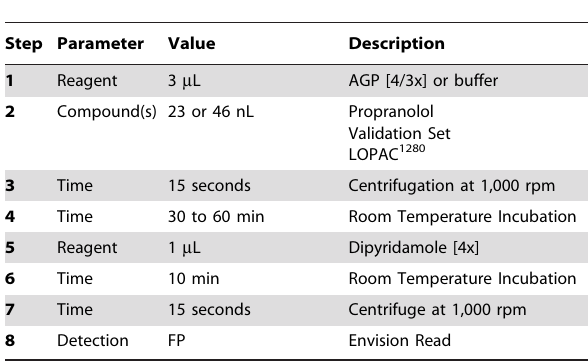
Table 1. AGP Assay Protocol for 1,536-well Format.